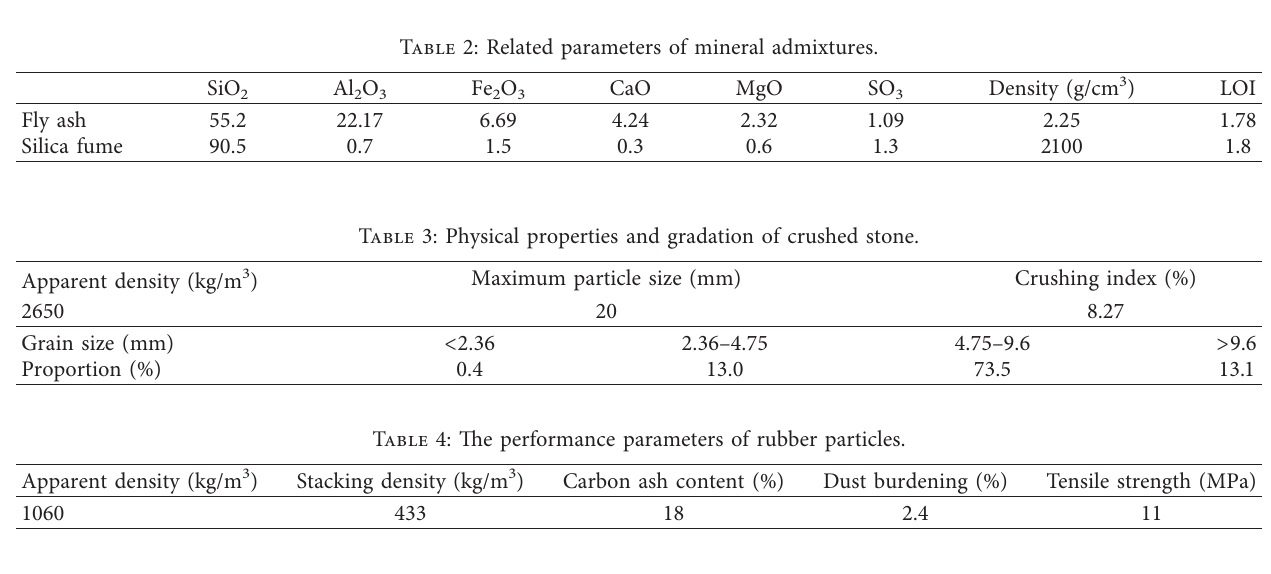
Table 5: The mixture proportion of SCRC (kg/m 3 ).